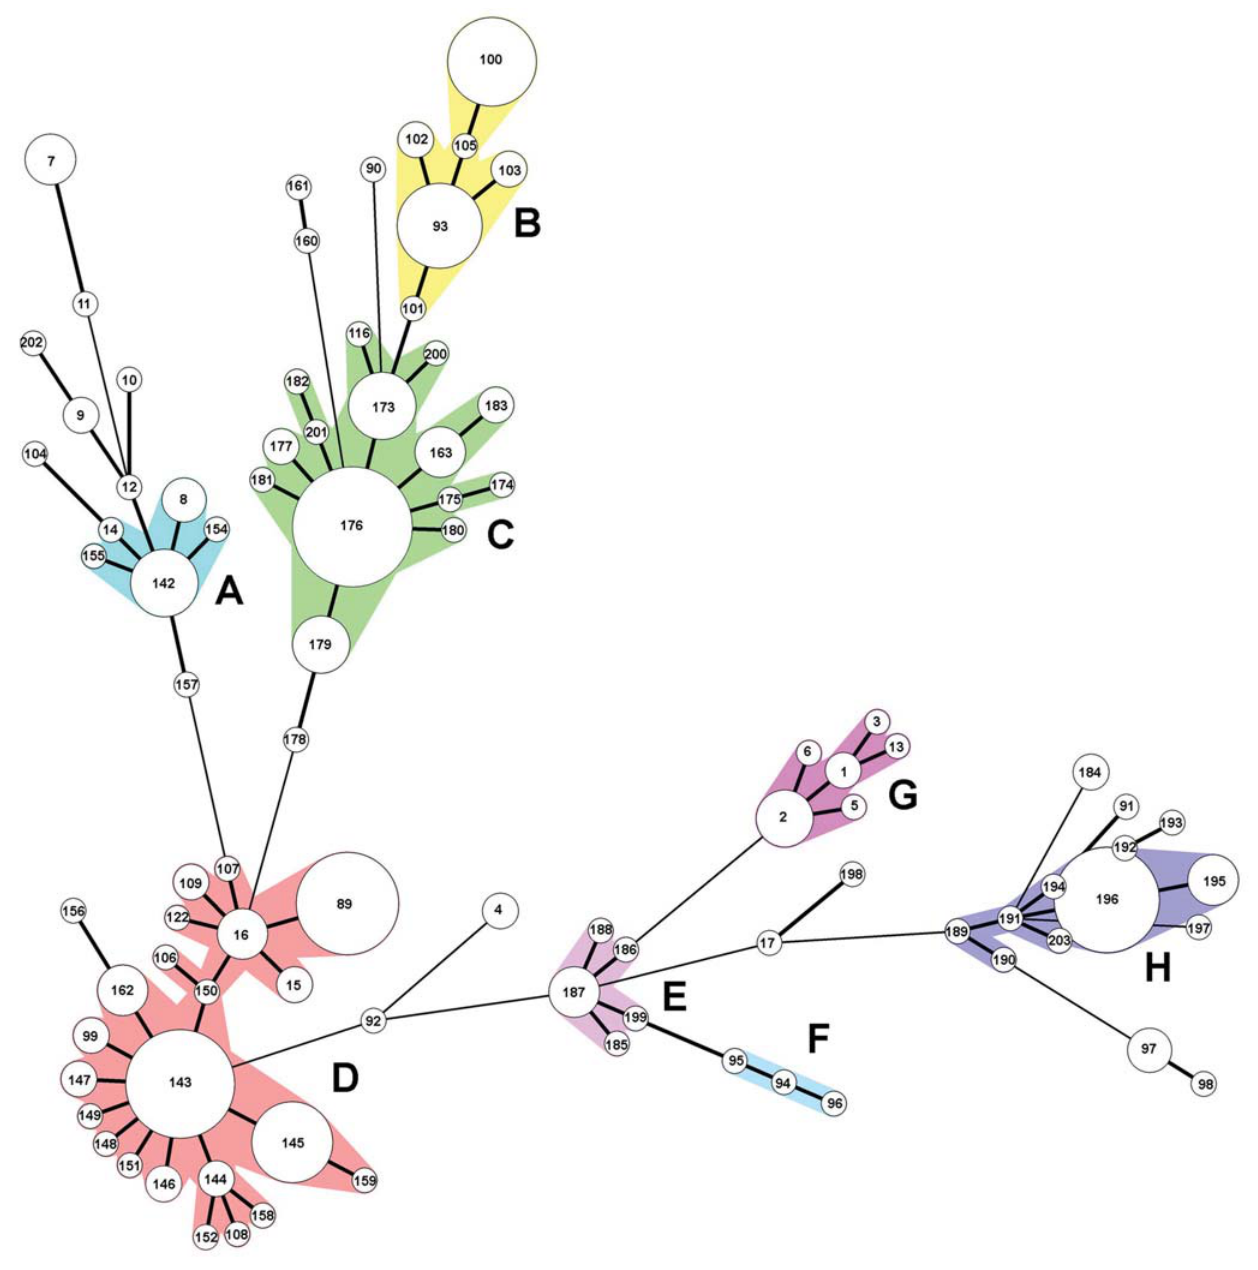
Figure 7. A comparison of the phylogenetic relationships among 92 MLVA types. The size of the circles indicate relative number of isolates of each MLVA type (numbers in the circles) recovered from the environment. Those MLVA types shown with the smallest circles were isolated only once. Letters A–H indicate clusters (colored regions) in which types differ at only 1 of the 10 MLVA loci from a neighbor.